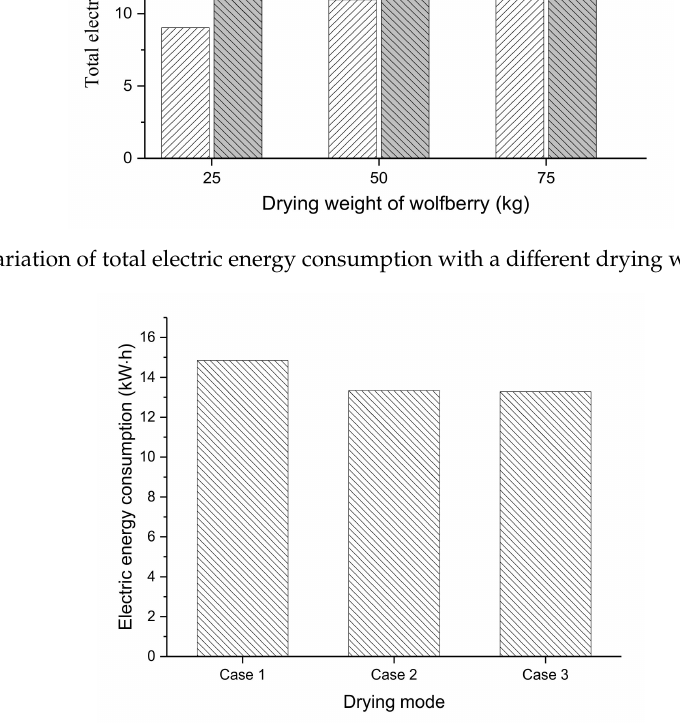
Figure 16. Electric energy consumption of the solar assisted heat pump drying system on a di ff erent temperature